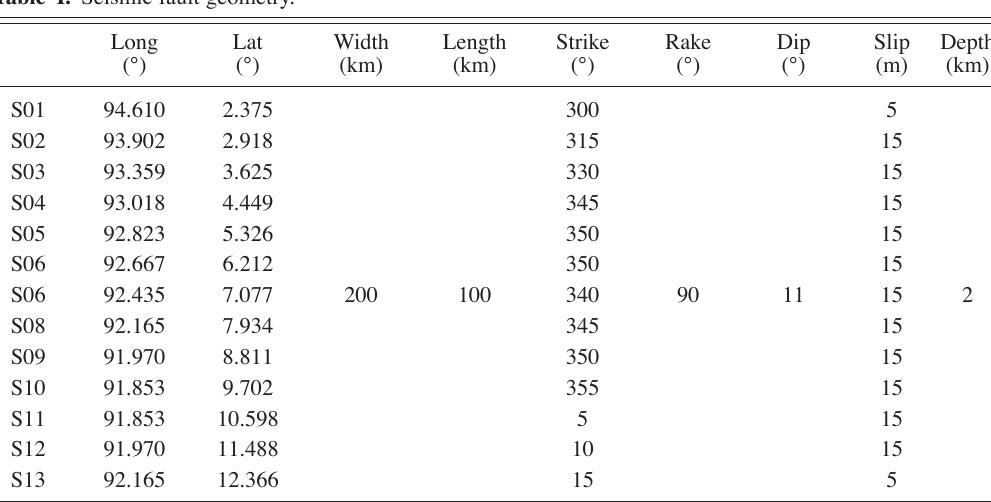
Table I. Seismic fault geometry. Long Lat Width Length Strike Rake Dip Slip Depth